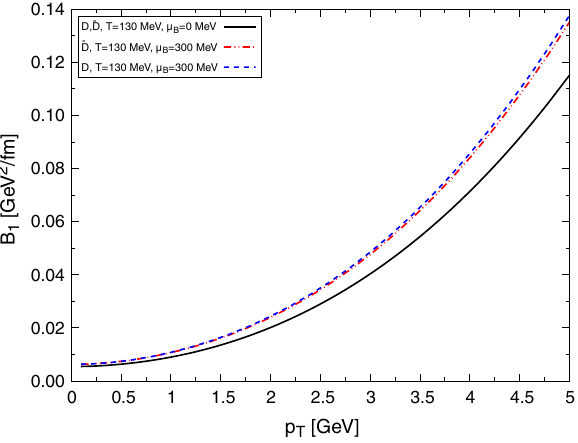
Fig. 7 B 1 coefficients at different temperatures for D and ¯ D mesons, taking into account a fugacity